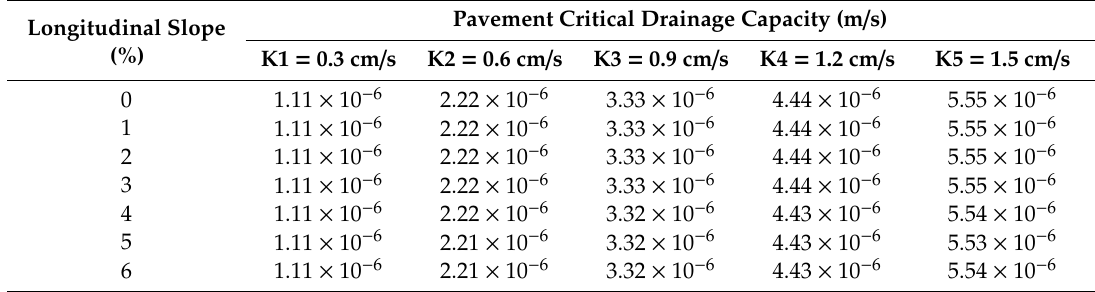
Table 7. Calculation result of critical drainage capacity of pavement with di ff erent transverse slope of 1% for the first boundary